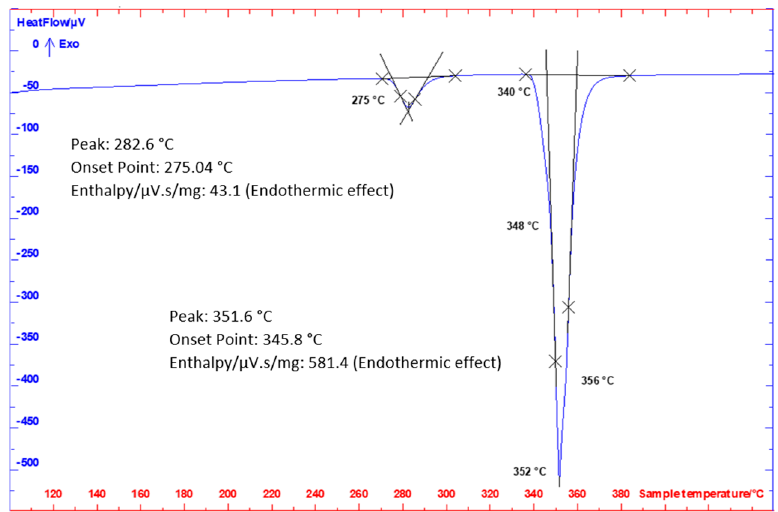
Figure 6. The differential scanning calorimetry (DSC) record for Zn5Al3Mg alloy, heating rate 5 Figure 6. The di ff erential scanning calorimetry (DSC) record for Zn5Al3Mg alloy, heating rate 5 ◦ C / min. °C/min.